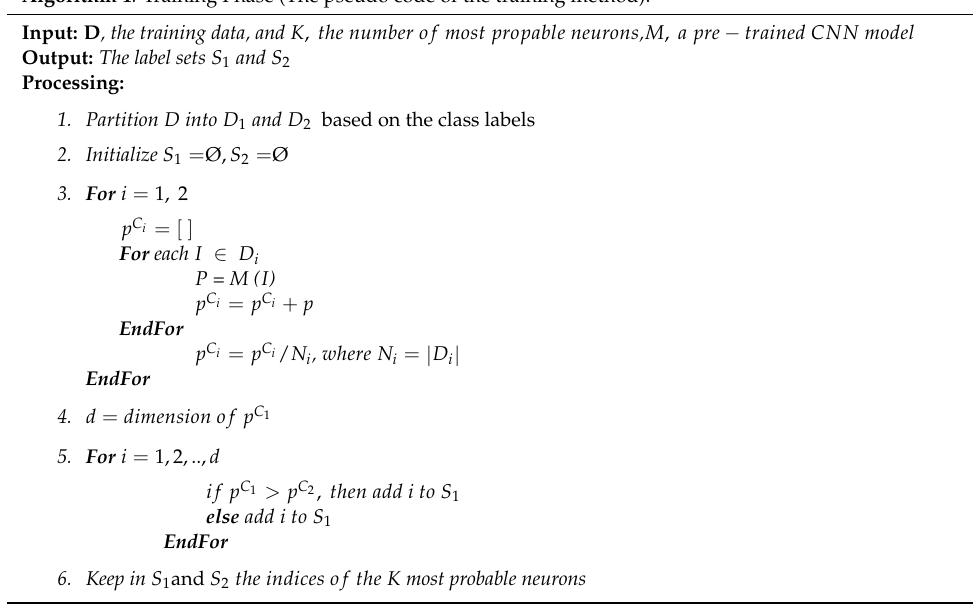
Algorithm 1 : Training Phase (The pseudo code of the training method).